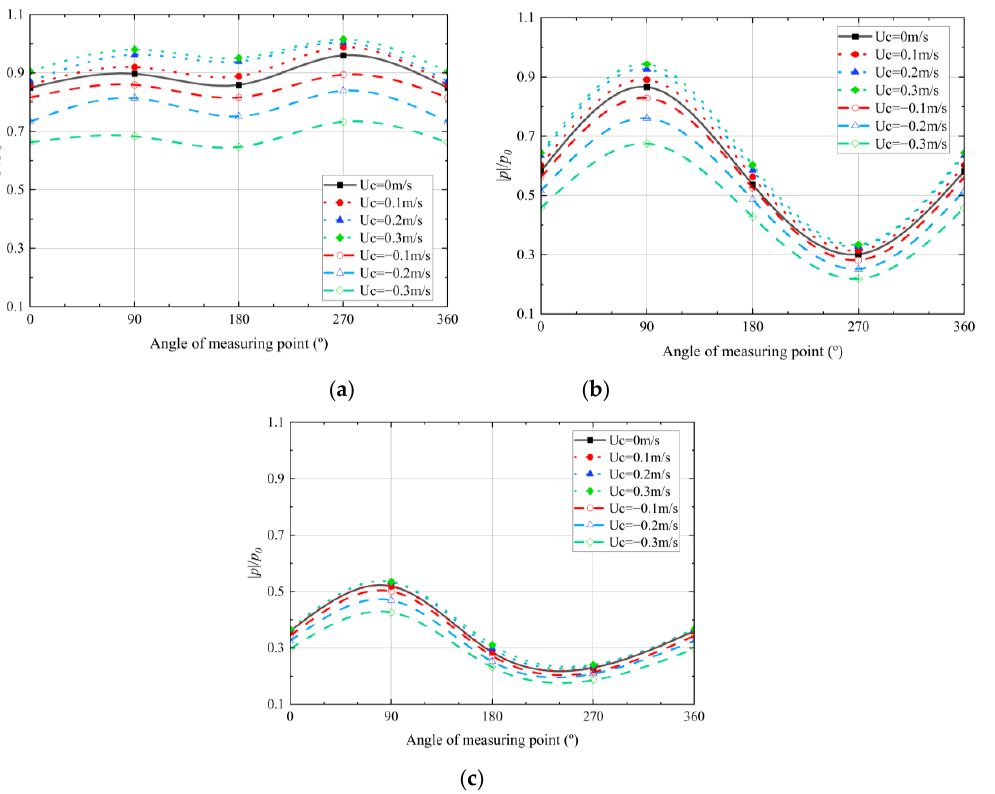
Figure 4. Variation of the dimensionless pore pressure amplitude around the pipeline with different backfill depths and current velocities. ( a ) e/D = 0; ( b ) e/D = 1; ( c ) e/D =